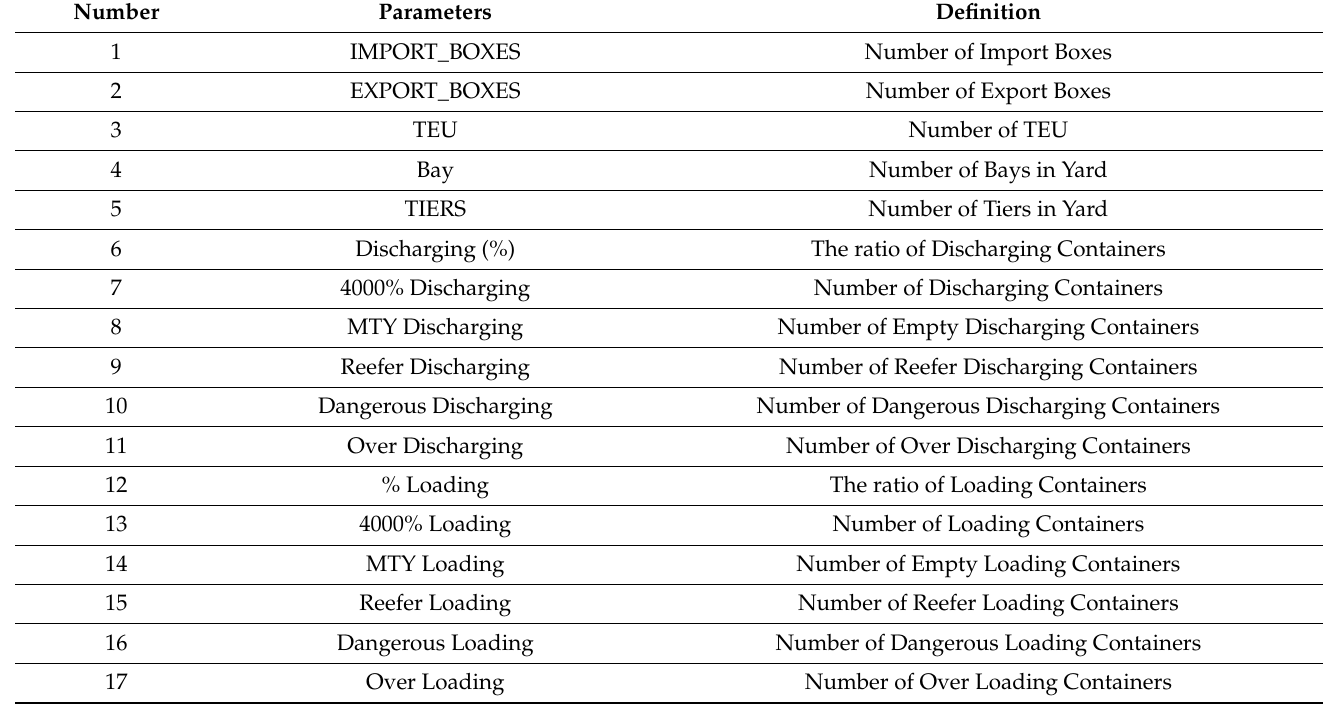
Table 2. Port data terminologies and their